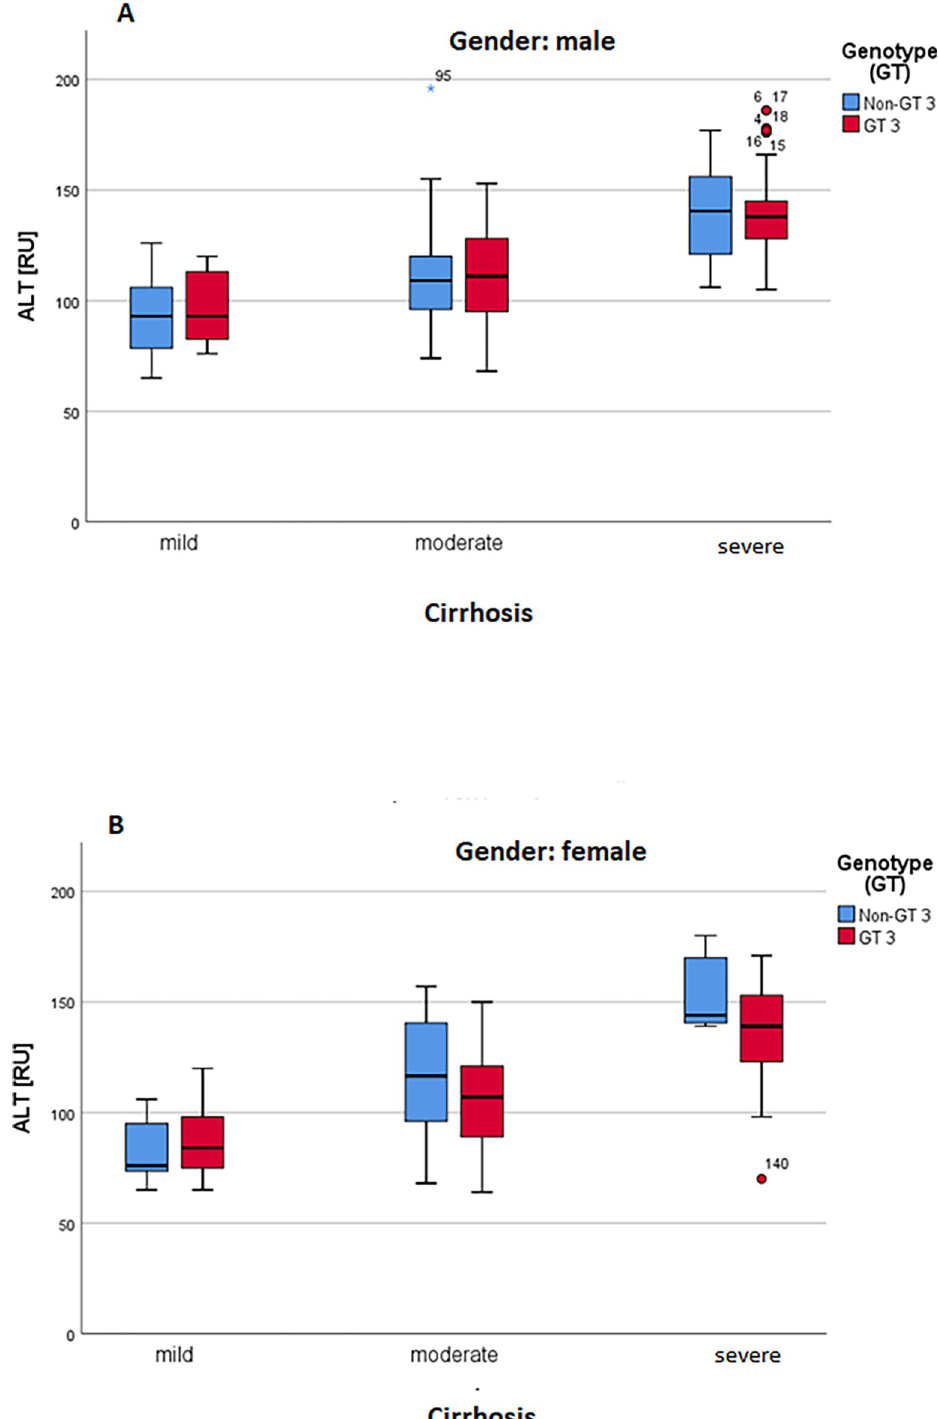
Fig 8. A, B: Grouped boxplot of ALT steps: cirrhosis and genotypes.